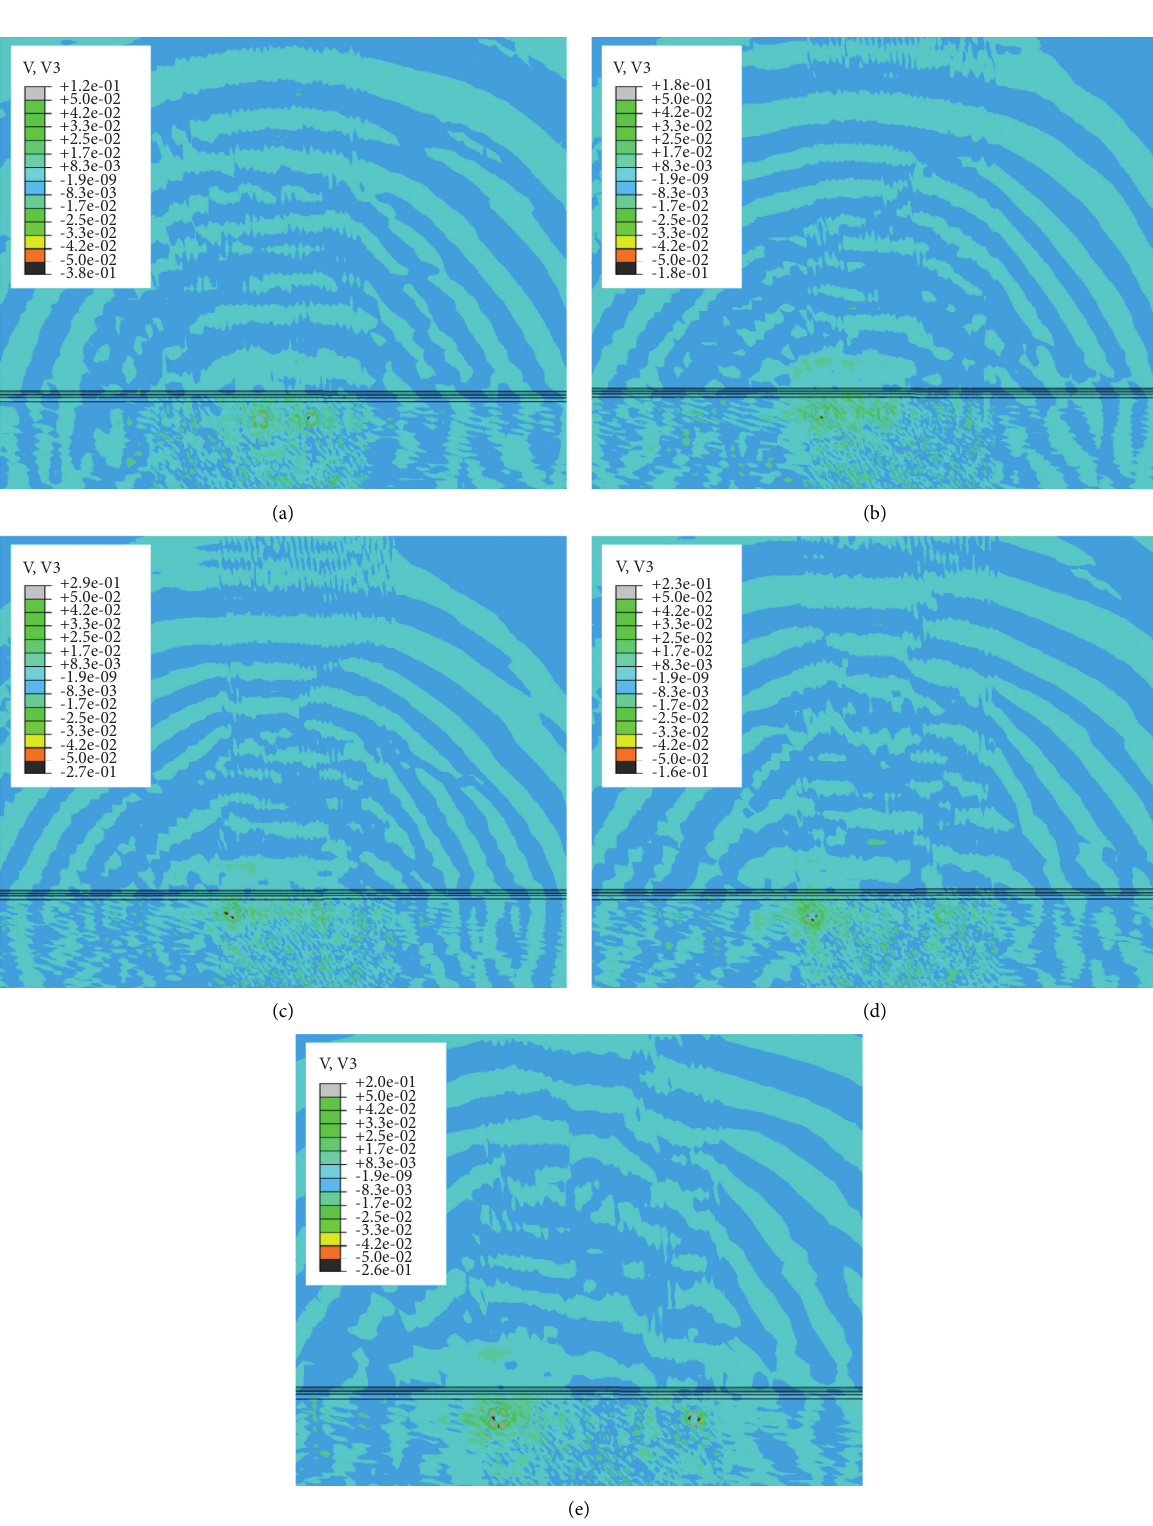
Figure 8: Comparison of the cloud plots of the peak vertical vibration velocities at different measuring points with different distances between the compactors (m/s; for the horizontal arrangement): (a) two hammer distances of 15m, (b) two hammer distances of 20m, (c) two hammer distances of 30m, (d) two hammer distances of 40 m, and (e) two hammer distances of